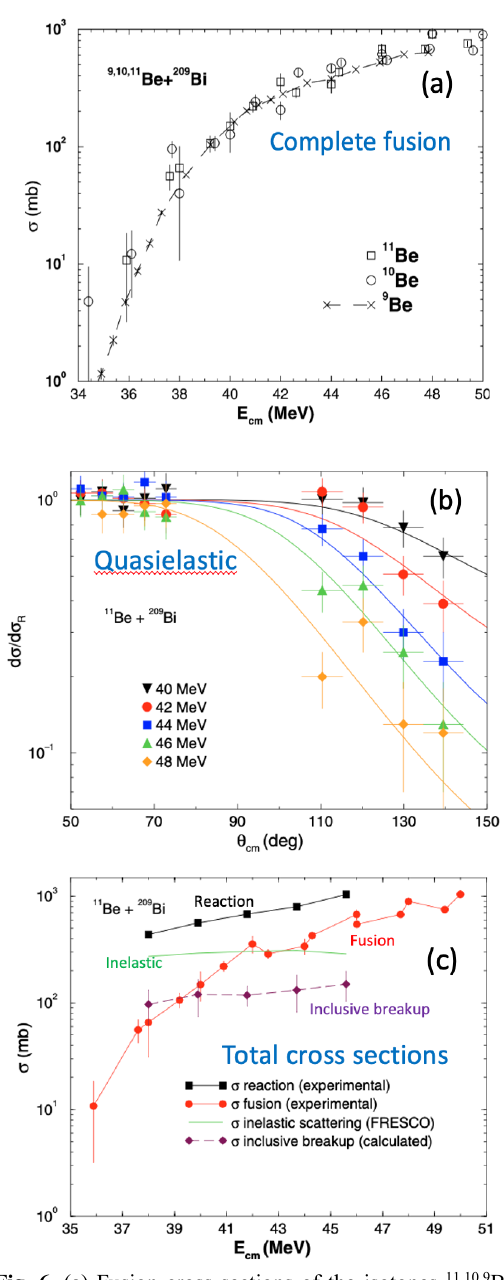
Fig. 6. (a) Fusion cross sections of the isotopes 11,10,9 Be with a 209 Bi target [28]. (b) Angular distribution of the quasielastic cross sections for 11 Be + 209 Bi for E = 40 - 48 MeV [29]. (c) Energy dependence of the reaction cross sections, fusion, inelastic and breakup. See text for